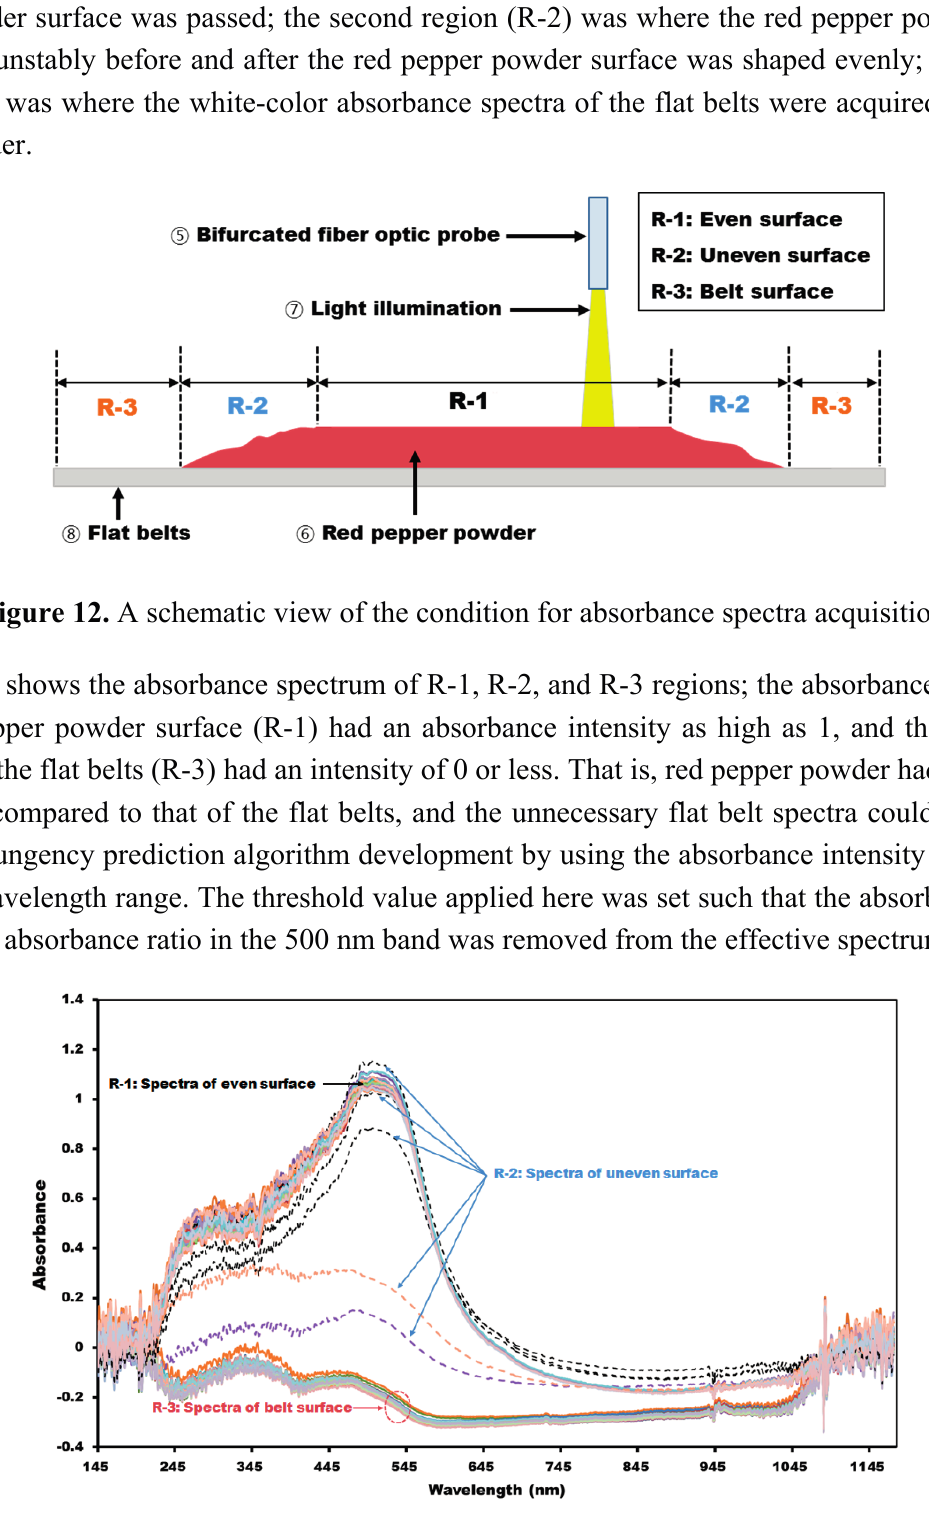
Figure 13. Spectrum shapes measured from the even or uneven surface of red pepper powder and from the belt